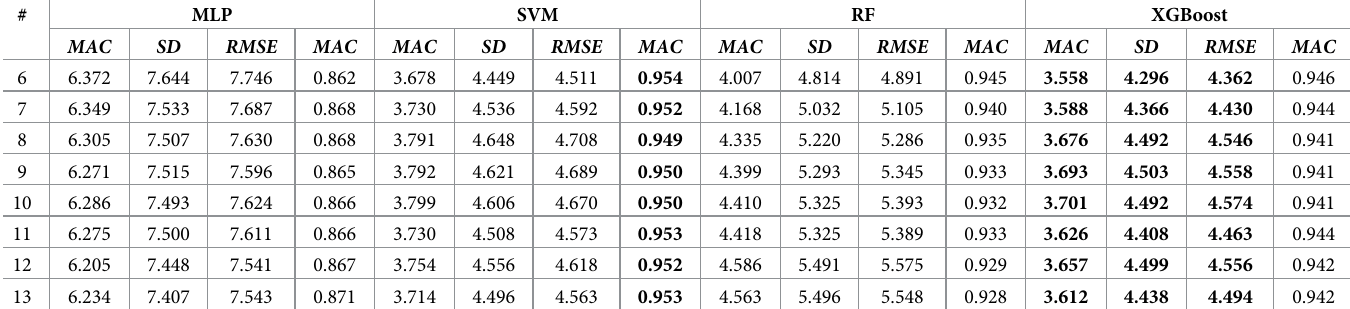
Table 7. Experimental results for the MLP, SVM, RF, and XGBoost, based on the StatLib dataset, with ICA feature extraction (best results are highlighted in bold; # means the number of features).